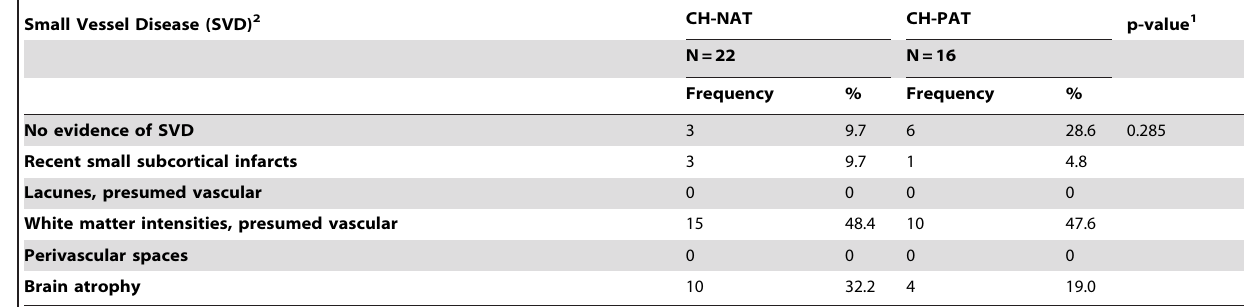
Table 7. MR imaging.